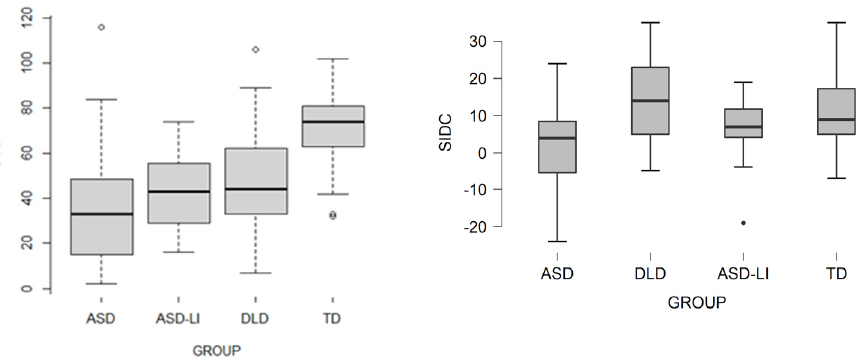
Figure 4. Boxplots for Children’s Communication Checklist-2 composites. GCC = General Com- munication Composite Children’s Communication Checklist-2; SIDC = Social-Interaction Deviance Composite Children’s Communication Checklist-2.